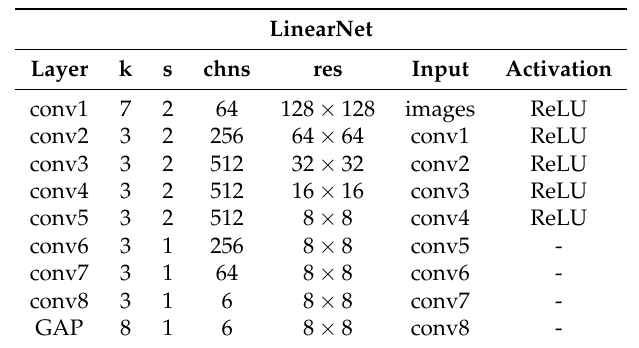
Table 1. LinearNet architecture. Here k is the kernel size, s is the stride, chns is the number of output channels for each layer, res is the input image resolution, and input corresponds to the input of each layer, conv* denotes convolutional